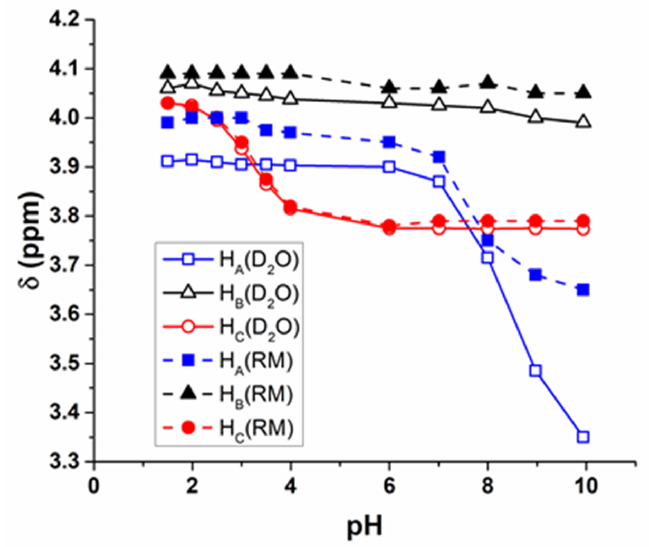
Figure 4. GGG proton shifts compared at varying pH values in aqueous (D 2 O) and RM environments, as determined by 1 H NMR spectroscopy. RMs of size w 0 10 were formed with 200 mM GGG in D 2 O. Error bars on the graph are smaller than the symbols used. GGG protons are labeled according to Figure 1D.